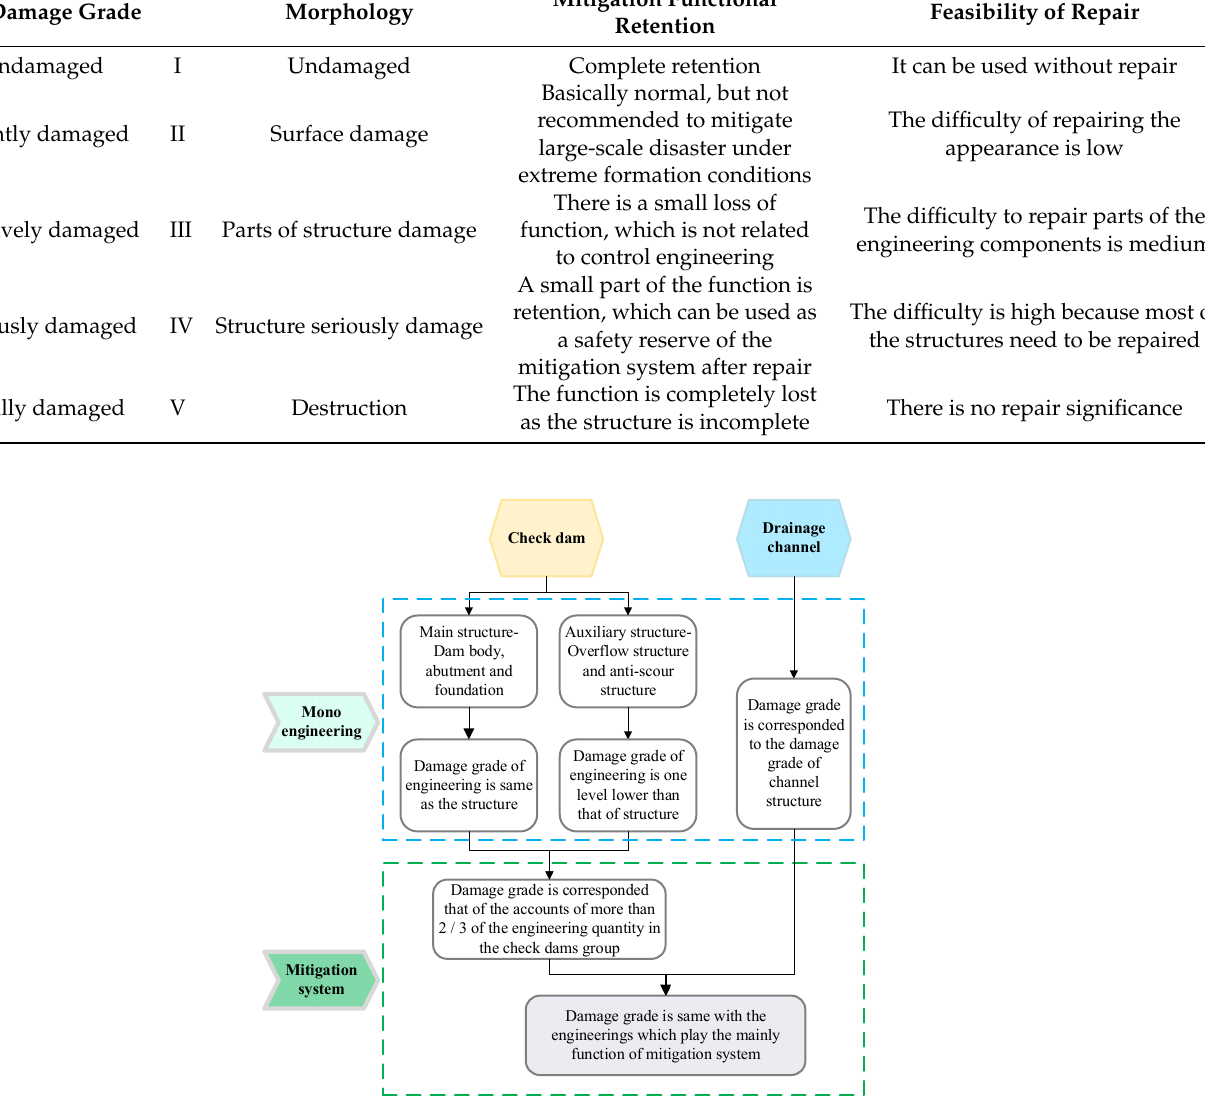
Figure 2. The classification method of damage grade for debris flow mitigation engineering.